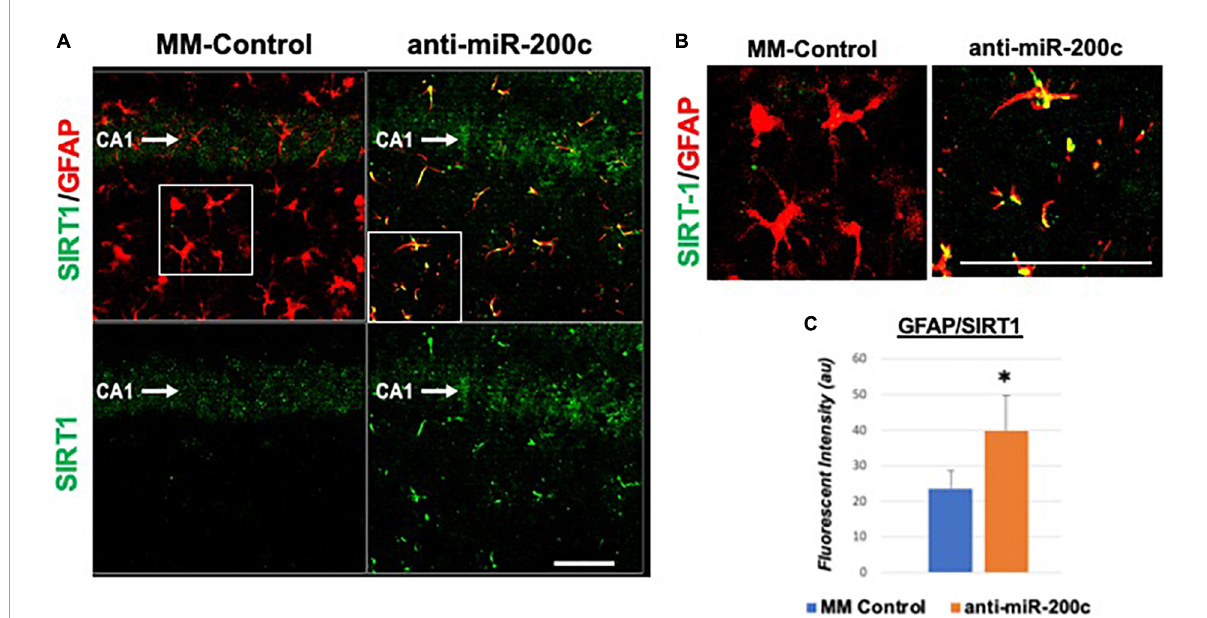
FIGURE5 Astrocyte-specific CA1 SIRT1 expression after global cerebral ischemia in mice. Low power (200 × , A ) and high power (600 × , B ) representative images of fluorescent IHC labeling of hippocampal GFAP (red) and SIRT1 expression (green) 7 days after global cerebral ischemia with and without IV anti-miR-200c post-treatment. Quantification of co-labeled GFAP/SIRT1 (C) in CA1. N = 5–8 animals per treatment group, mean + SEM, * p < 0.05. Scale bar, 25 µ